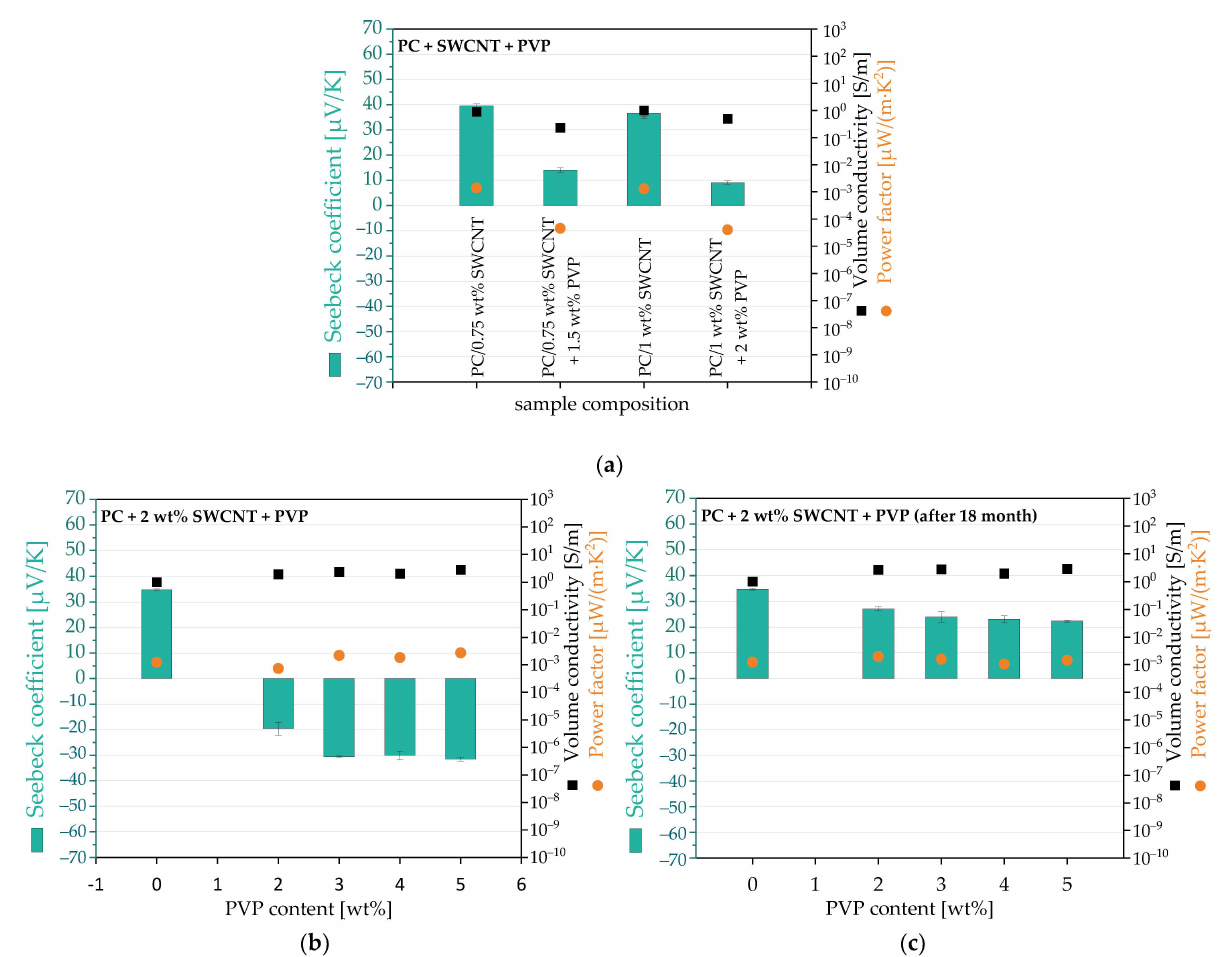
Figure 3. TE properties of PC composites with SWCNT Tuball: SWNT content of 0.75 and 1 wt% and PVP in the ratio 1:2 ( a ), PC/2 wt% SWCNT Tuball composites with different contents of PVP, first measurements ( b ), and measurements repeated after 18-month storage under ambient conditions ( c